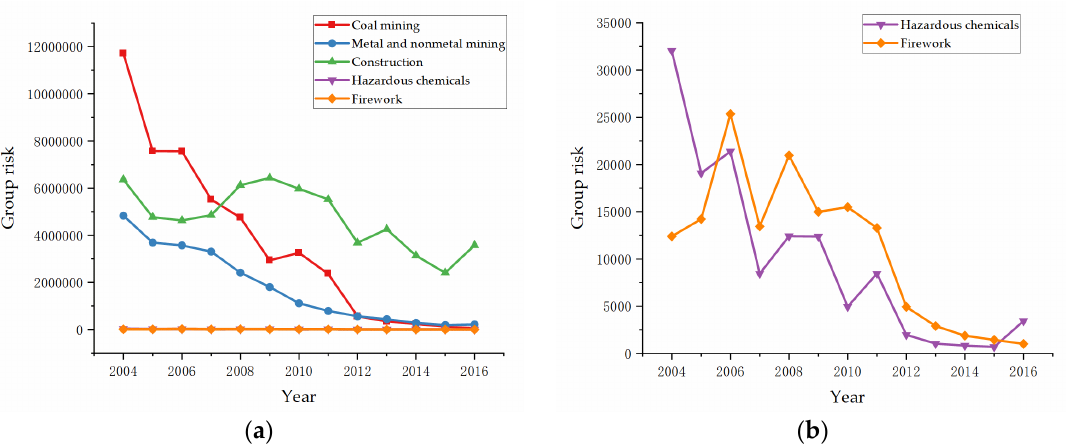
Figure 2. Group risk of high-danger industries: ( a ) Coal mining, metal and nonmetal mining, construction, hazardous chemicals, and firework; ( b ) hazardous chemicals and firework.